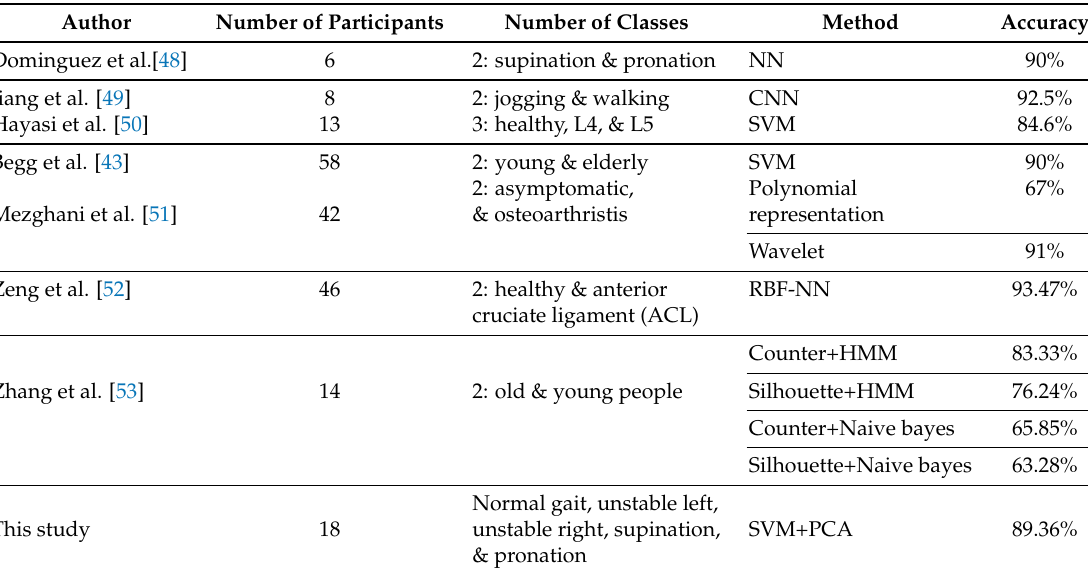
Table 10. Comparison of performance against related